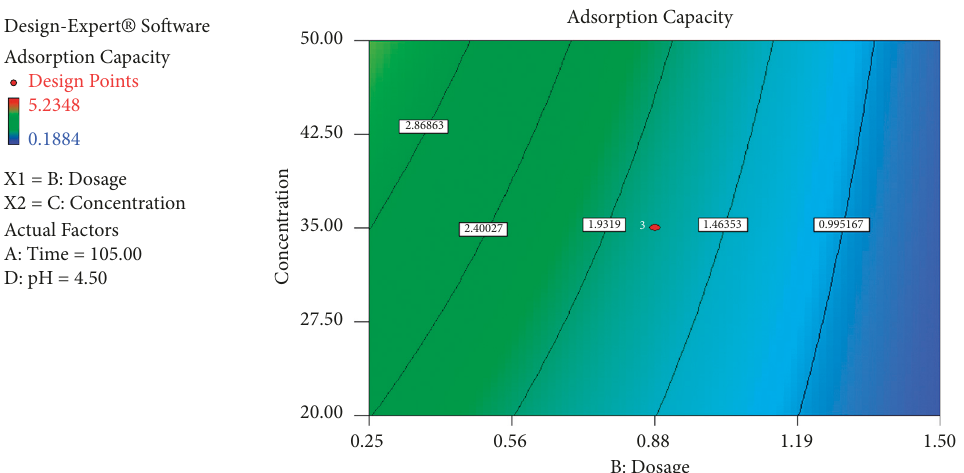
Figure 4: Contour plot for the interaction between adsorbent dosage and initial concentration on adsorption capacity of BRR dye.